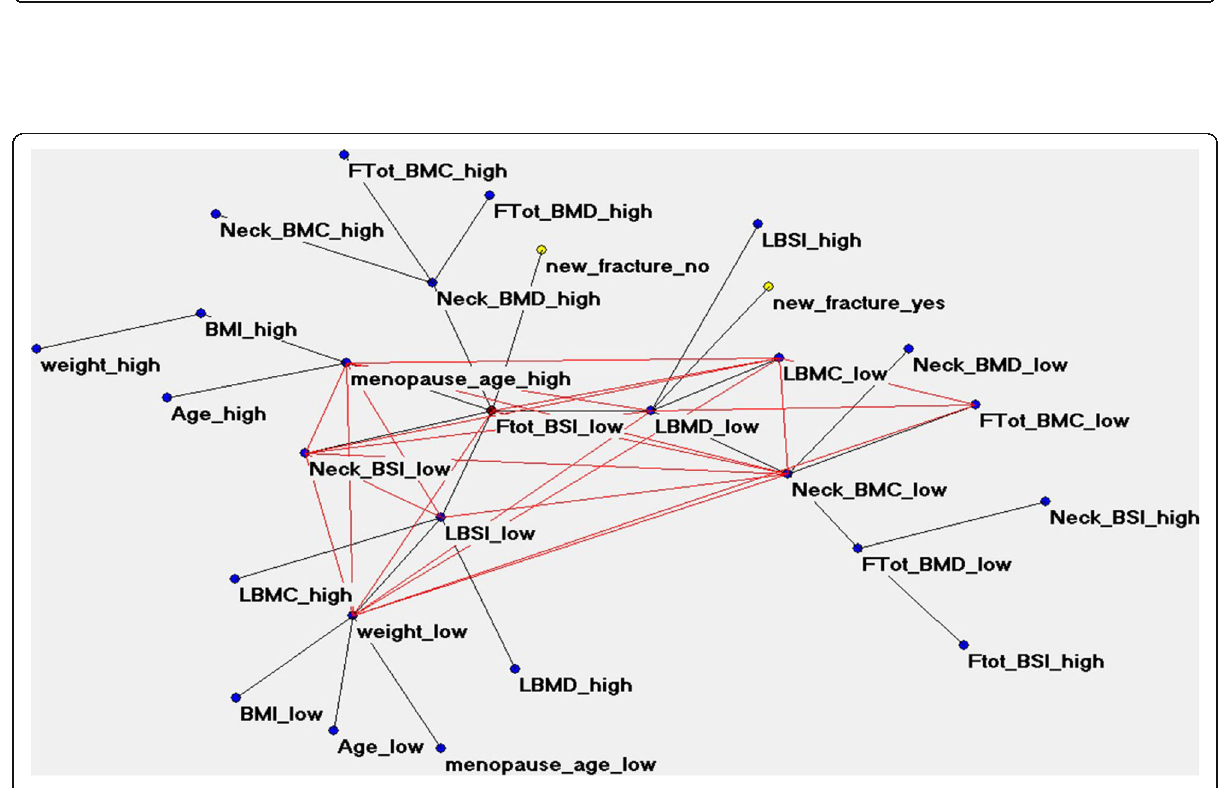
Fig. 5 ANN semantic connectivity map showing the different strength values of connectivity as numbers. Ftot, Total femur; BMC, Bone mineral content; BMD, Bone mineral density; BSI, Bone strain index; LBMC, Lumbar BMC; LBMD, Lumbar BMD; LBSI, Lumbar BSI. “ High ” refers to high values, “ low ” refers to low values